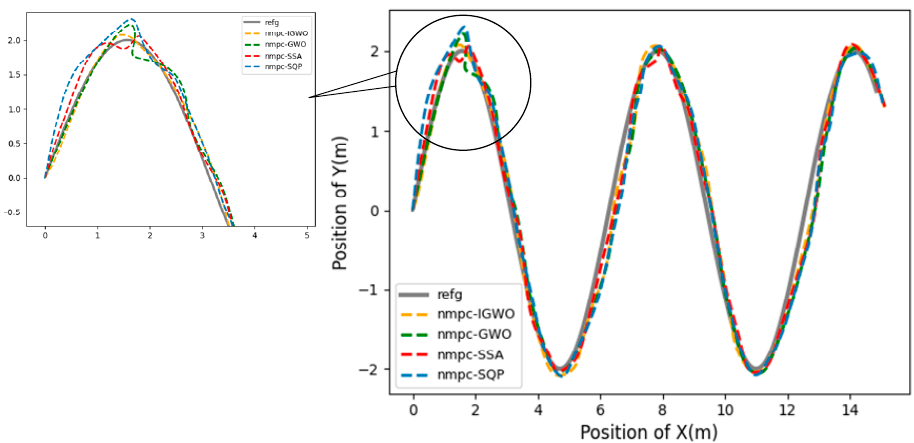
Figure 11. Comparison of tracking effect of IGWO, GWO and SSA algorithms.